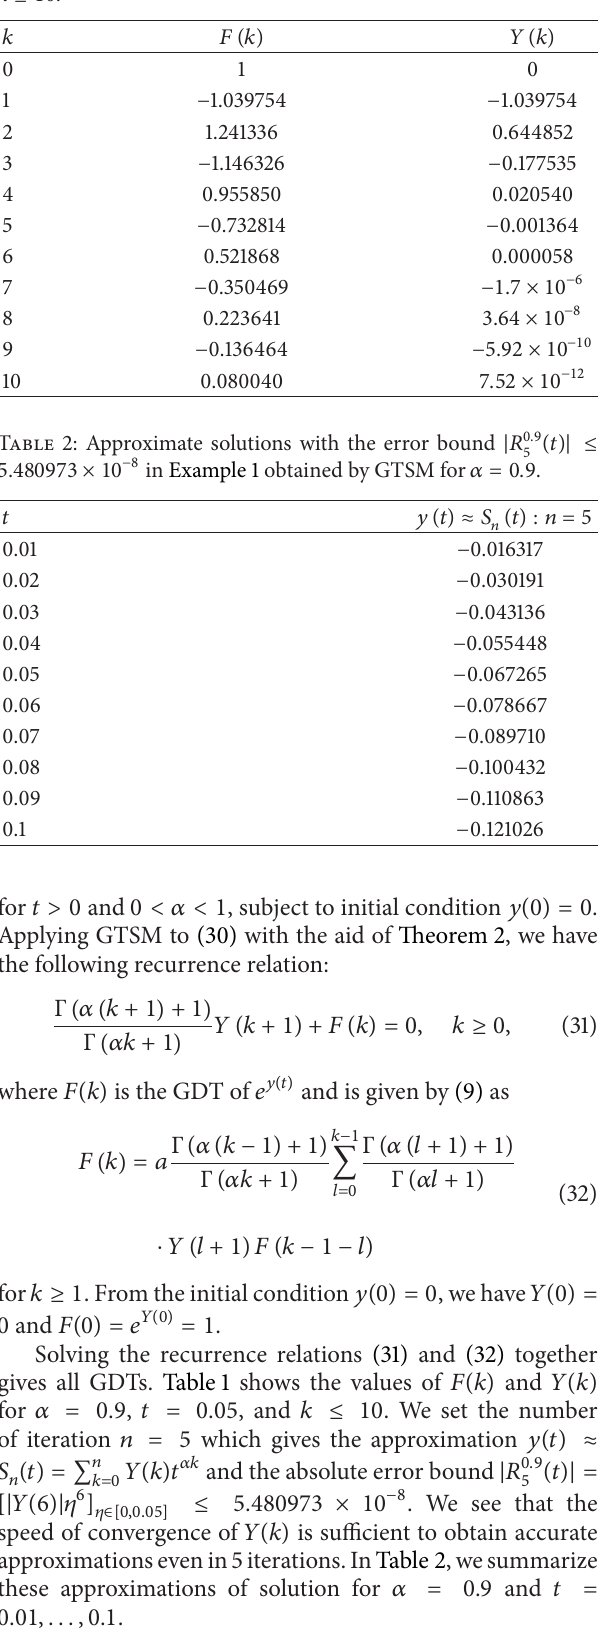
Table 1: 𝐹(𝑘) and 𝑌(𝑘) values in Example 1 for 𝛼 = 0.9 , 𝑡 = 0.05 , and 𝑘 ≤ 10 .